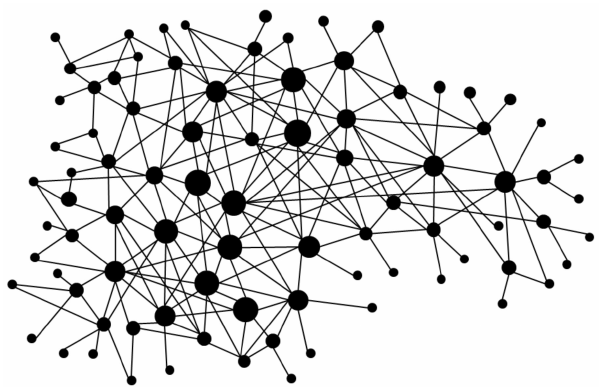
Figure 1. Schematic diagram of a complex